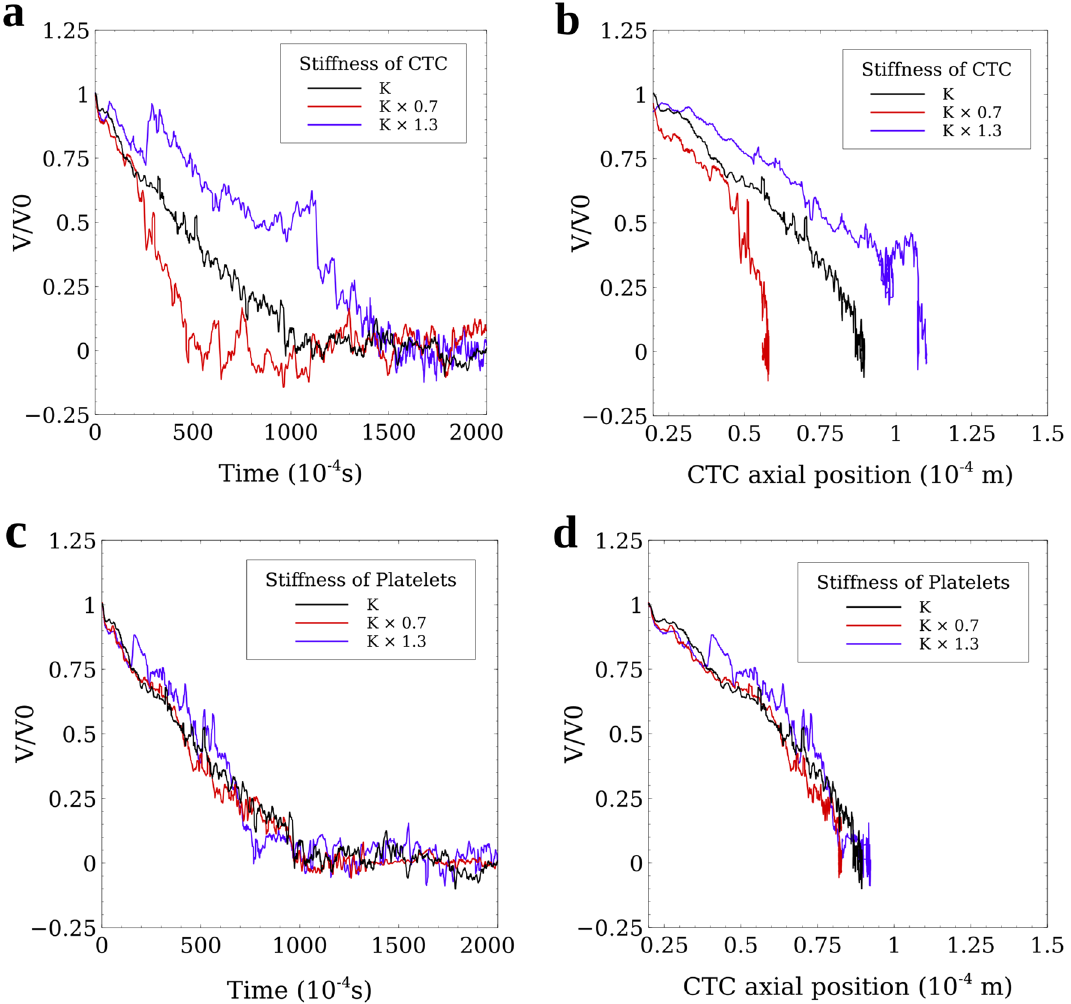
vessel wall than stiffer CTCs. A CTC by 30% softer (red line) leads to 50% decrease in the adhesion time while a 30% stiffer CTC causes a 50% increase in the adhesion time. Faster adhesion of softer CTCs is mainly because before firm adhesion occurs, mainly because they adhere faster than normal tumor cells; ( c ) The adhesion time of the CTC with attached platelets that are 30% softer or stiffer than the baseline platelets, does not have a